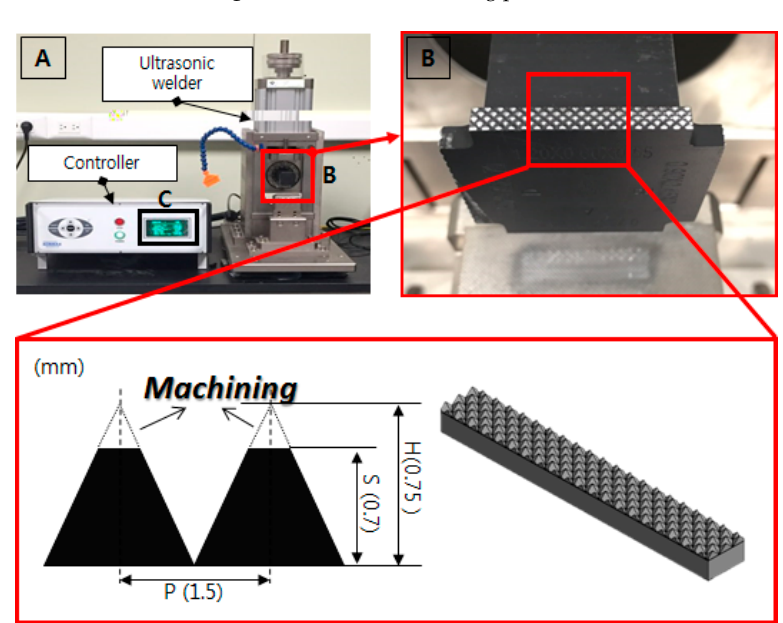
Figure 1. Ultrasonic welding process.